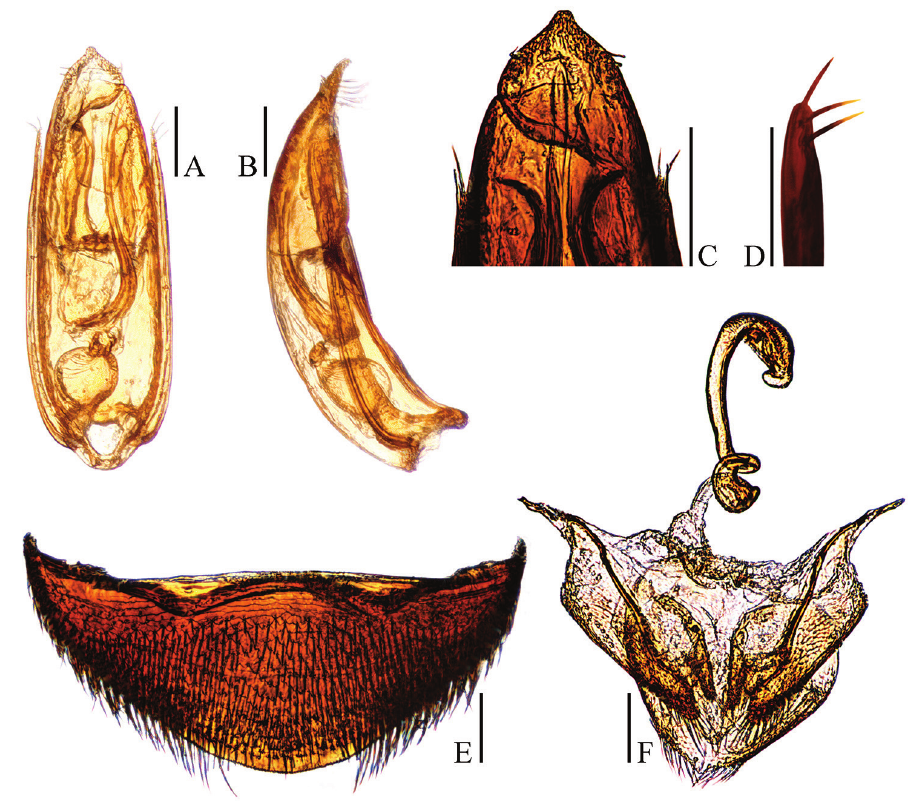
Figure 7. Ptomaphagus (s. str.) funiu sp. n. ( ♂ : paratype; ♀ : paratype). A aedeagus (dorsal view) B aedeagus (lateral view) C aedeagal apex (ventral view) D paramere apex (lateral view) E ventrite VIII ♀ (ventral view) F spermatheca, genital segment and ovipositor (ventral view). Scale bars: 0.1